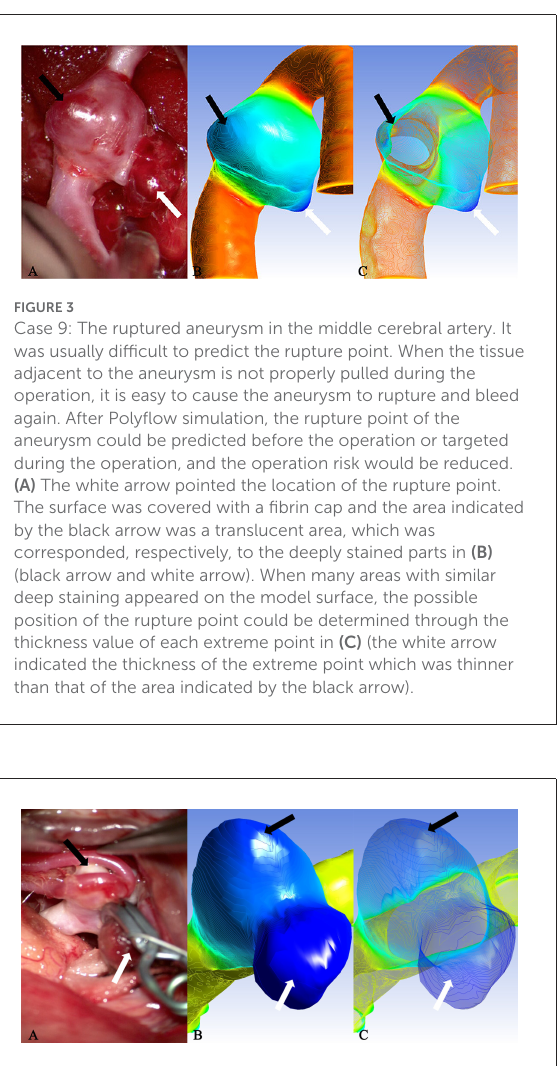
FIGURE4 Case 2: A ruptured aneurysm in the middle cerebral artery. (A) The aneurysm with a bleb had been cliped. The white arrow pointed the rupture point of the aneurysm, which was completely consistent with the deeply stained part in (B) as indicated by the white arrow (the darker area next to it was a shadow) and the minimum extreme point in (C) as indicated by the white arrow. The other extreme point (black arrow) in (C) and the lightly deep staining area (black arrow) in (B) failed to show the existence of a translucent area in the corresponding part (black arrow) on the surface of the real